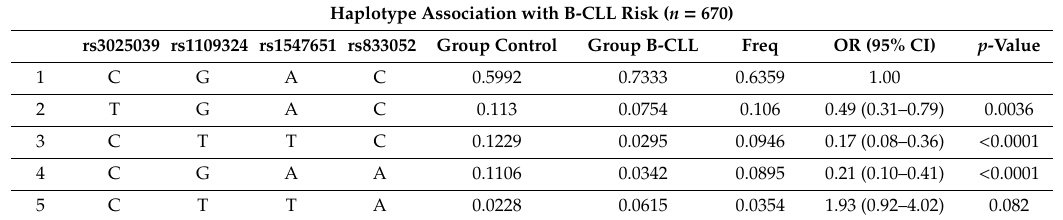
Table 4. Haplotype analysis of rs3025039, rs1109324, rs1547651 and rs833052 VEGFA SNPs and risk of developing B-CLL. The table shows haplotype frequency, odds ratio and p -value in genomic DNA from peripheral blood of all participants in this study. The haplotypes frequencies for the control group and the B-CLL group are shown in columns six and seven, respectively.